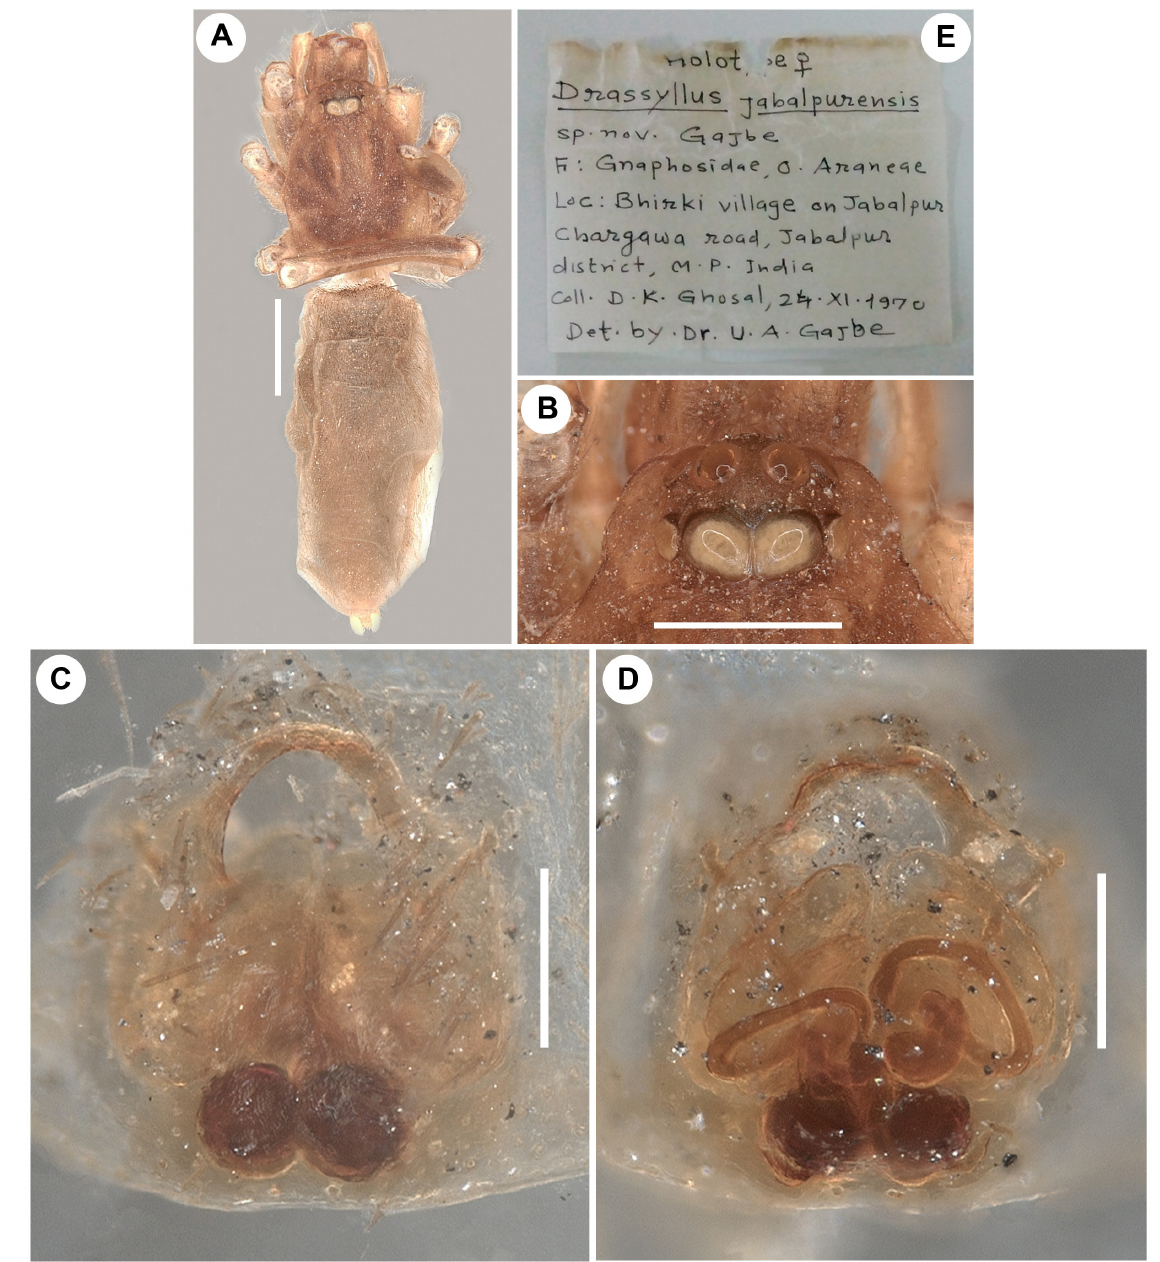
Fig. 2. Cryptodrassus khajuriai (Tikader & Gajbe, 1976) comb. nov ., ♀, holotype of Drassyllus jabalpurensis Gajbe, 2005 (NZC-ZSI-5452/18). A . Habitus, dorsal view. B . Eyes of the same, dorsal view. C . Epigyne, ventral view. D . Same, dorsal view. E . Label from type bottle. Scale bars: A = 1 mm; B = 0.5 mm; C–D = 0.2